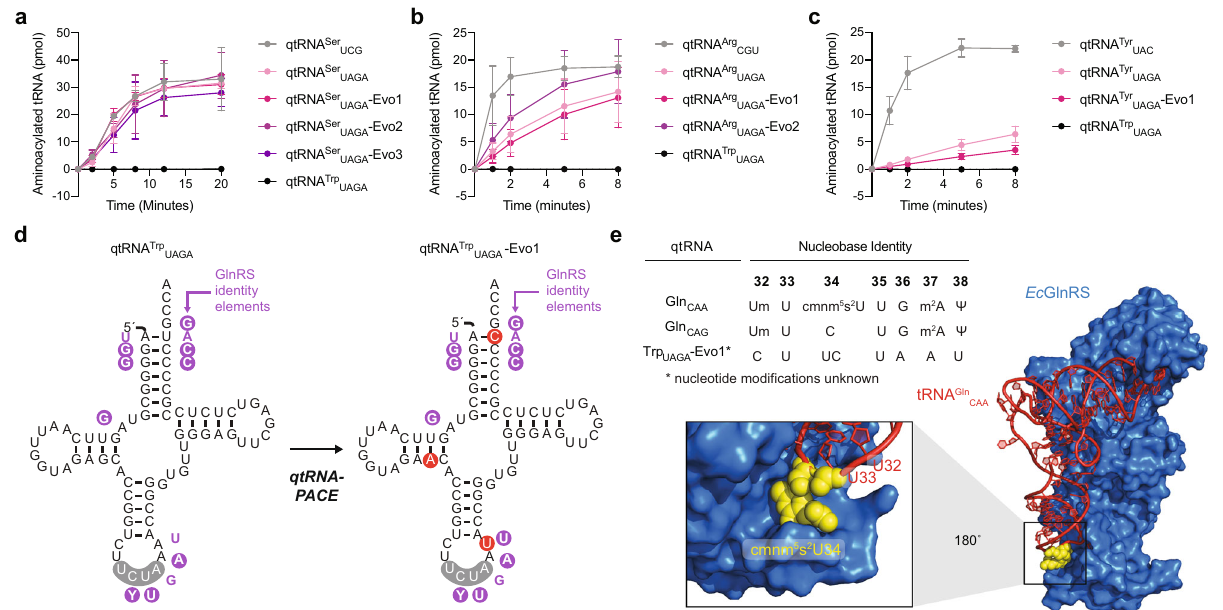
Fig. 3 In vitro analysis of evolved qtRNAs. In vitro aminoacylation of qtRNAs using Ec SerRS ( a ), Ec ArgRS ( b ), and Ec TyrRS ( c ); qtRNA Trp UAGA was used as a negative control in all cases. d Analysis of Ec GlnRS identity elements as found in the engineered qtRNA Trp UAGA and qtRNA-PACE evolved qtRNA Trp UAGA - Evo1. e Anticodon and adjacent nucleobase identities for known E. coli glutamine tRNAs and the qtRNA-PACE evolved qtRNA Trp UAGA -Evo1. Position of the modi fi ed nucleotide cmnm 5 s 2 U (yellow) in the co-crystal structure of tRNA Gln CAA and E. coli GlnRS (4JYZ; https://www.wwpdb.org/pdb? id = pdb_00004jyz). Data represent the mean and standard deviation of three biological